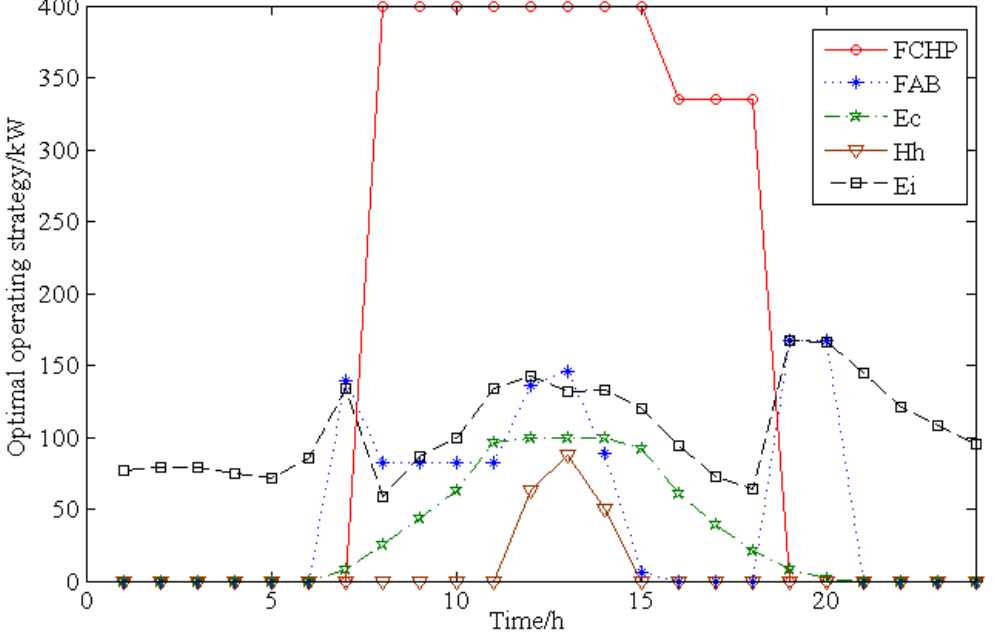
Figure 14. Optimal hourly operation strategy for each equipment of the regional system within a day.